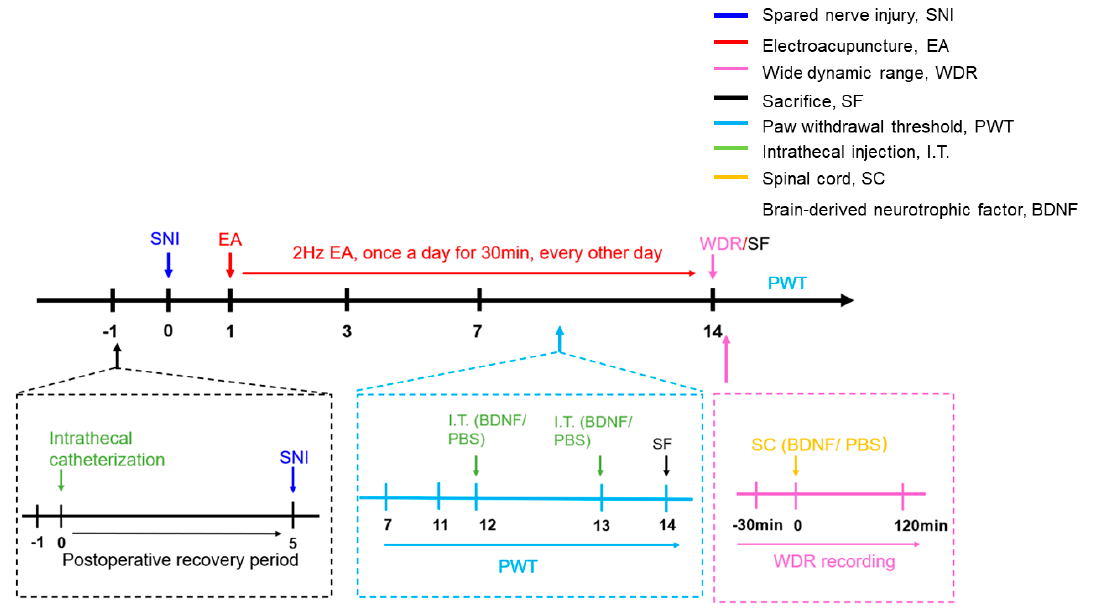
Figure 8. The schematic diagram of the experimental protocols.